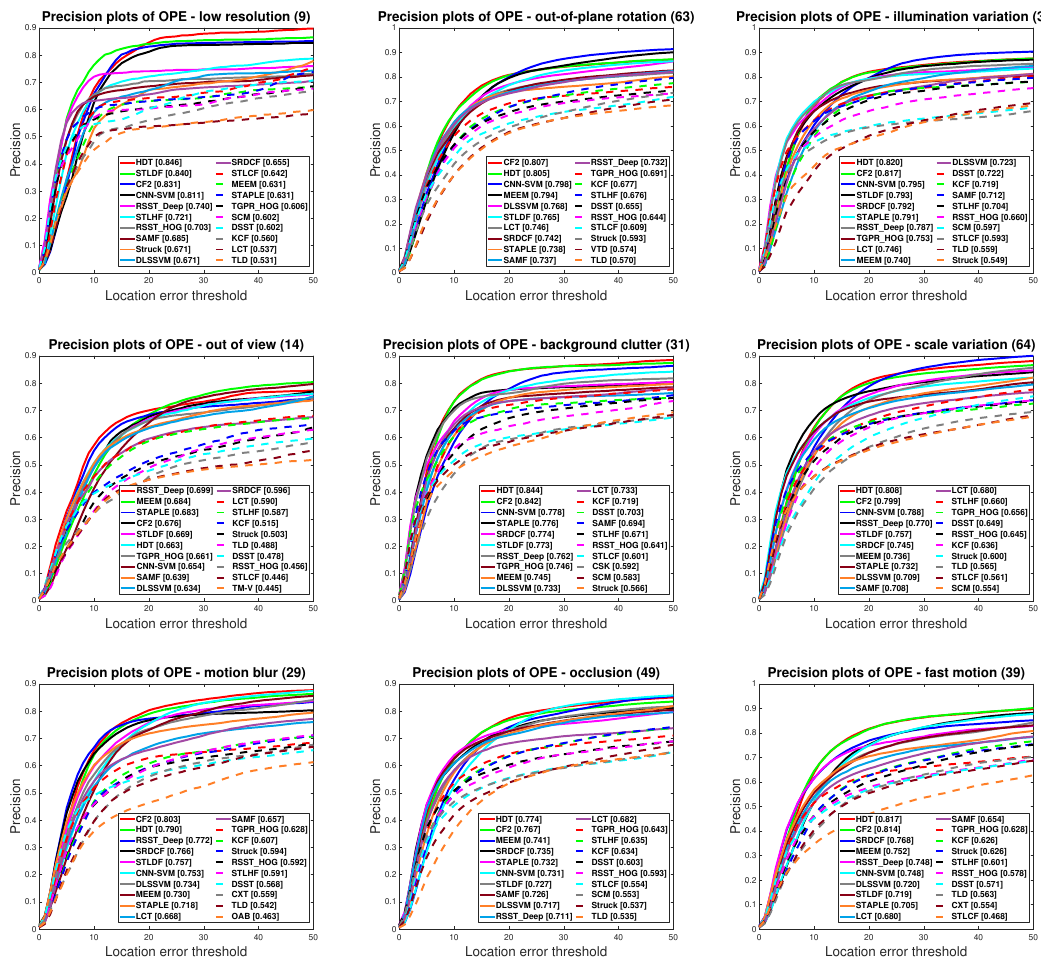
Figure 5. The OPE precision plots for LR, OPR, IV, OV, BC, SV, MB, OCC, and FM subsets in